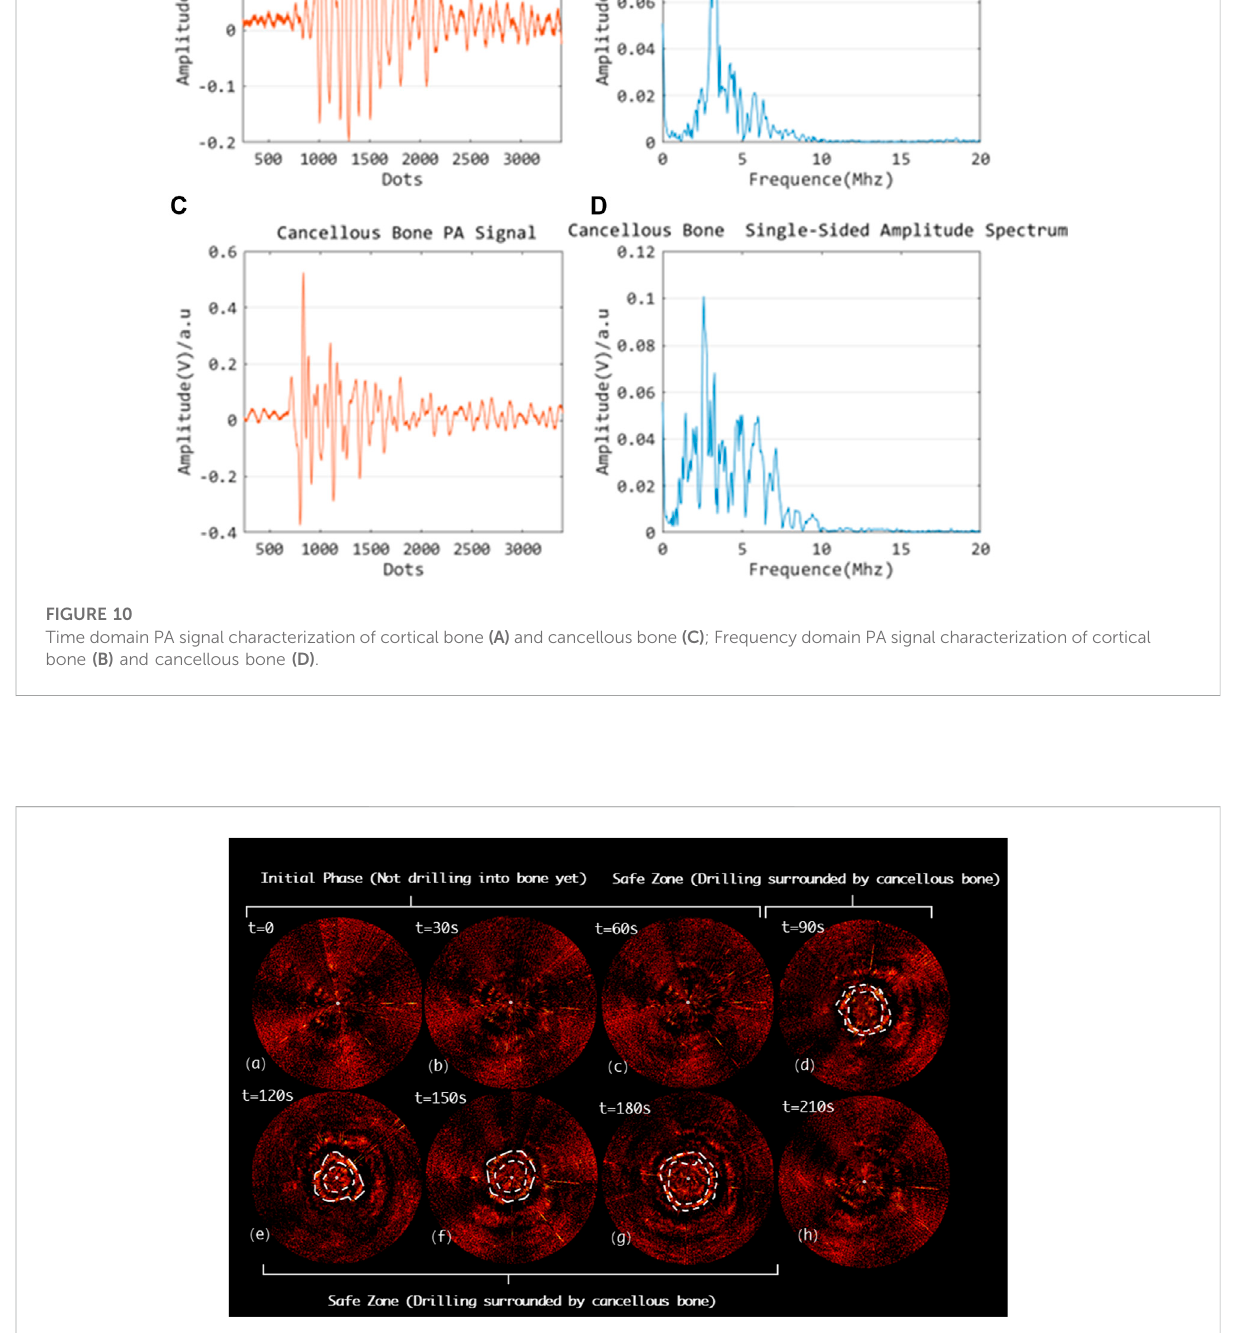
Frontiers in Bioengineering and